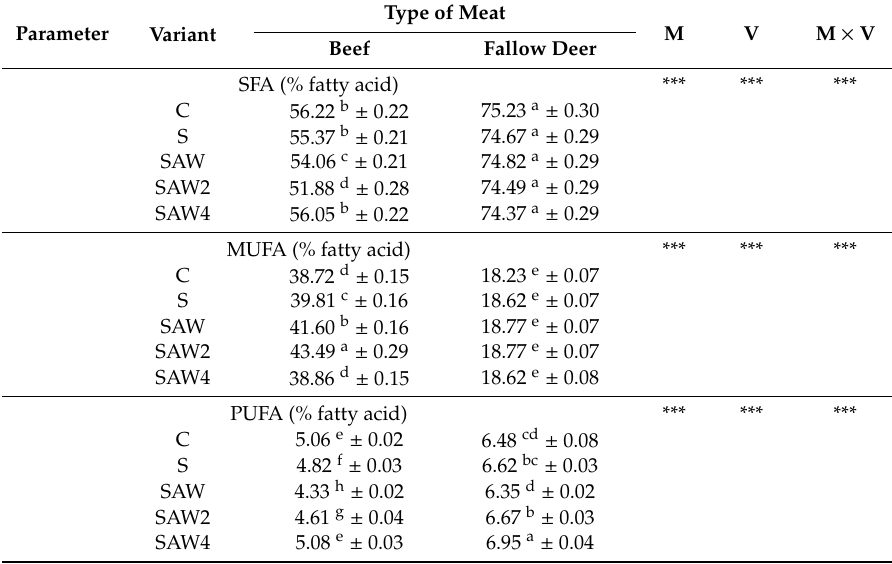
Table 7. Main fractions of fatty acid profile of fermented sausages made from fallow deer and beef meat with di ff erent additives (mean ± standard